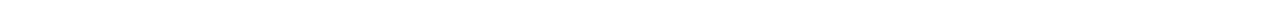
Fig. 5 Curvature sensing-mediated cortical protein waves always re fl ect protein recruitment from cytoplasm onto membrane. a Time curve of wave speed. The analytic result was obtained by computing the analytical solution (Eq. (2.24)), in which we took the membrane shape at the wavefront from the full model simulation as the input, and fi xed all the other parameters in the formula in accordance to the corresponding full model case. We note that there is one parameter in the analytic formula that cannot be analytically derived from the reaction rates in the full model. Instead, we can numerically determine the range of its value (Supplementary Note 2), which re fl ects on the gray zone in the analytic results. b Time curve of diffusional contribution to wave propagation. c Diffusion-dependence of wave propagation. b , c Relative diffusion contribution to wave propagation is de fi ned as the ratio between the diffusion term and the reaction term in the dynamic equation of F-BAR (Eq. (1.3) of the full model, Supplementary Note 1). And we chose the location ahead of the wavefront, where the absolute value of membrane curvature is the highest. Variation in this location does not change the qualitative conclusions from these plots. d , e Schematics of curvature sensing-mediated inhibitory effects on diffusional contribution to wave propagation. d Traveling wave from conventional reaction-diffusion system. e Curvature sensing-driven traveling wave. In d the “ h ” represents a chemical concentration in a generic sense, whereas the “ h ” in e is the membrane height and ∇ 2 h is the membrane curvature. The round disk represents a cortical protein “ F ” . We emphasize that the comparison here is only within the regime of traveling waves, not stationary wave phenomena that could emerge with characteristic spatial periodicities from conventional reaction-diffusion systems. f Inverse relationship between wave speed and the spatial gradient of cortical protein density at wavefront. The experimental data were collected from 37 waves in 8 cells. The F-BAR intensity for each wavefront was normalized to the maximum value within the individual cell. The gray shade represents the tracking measurement uncertainty (Supplementary Figs. 8 and 9). g Representative montage of FBP17 punctum during the apparent wave propagation show that each punctum assembles and disassembles at a fi xed